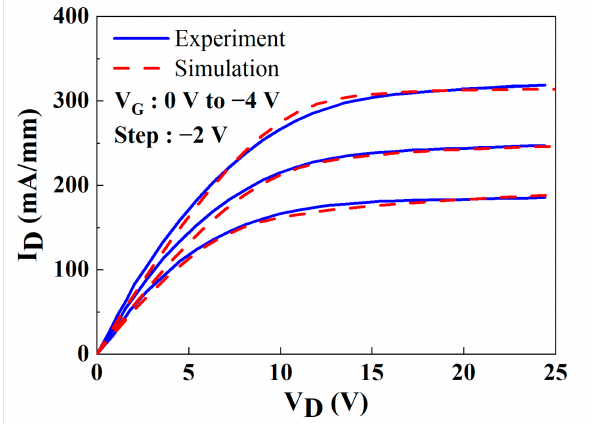
Figure 4. The experimental and simulated output performance of the β -Ga 2 O 3 MOSFET.